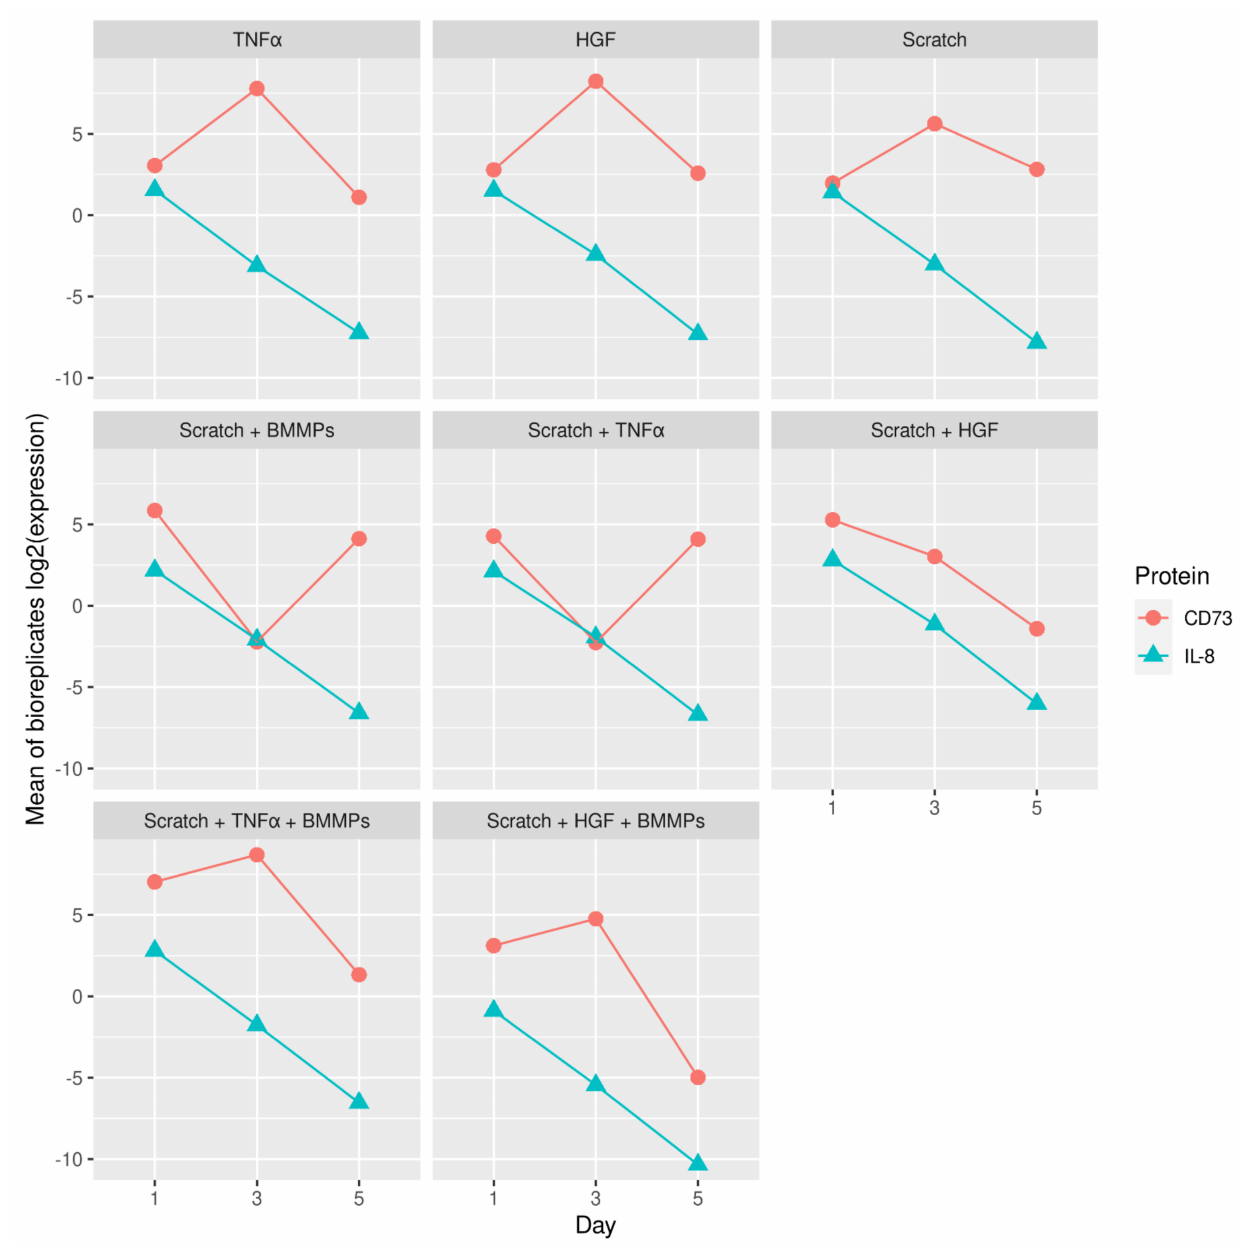
Figure A2. Log2 expression of the mean of three biological replicates for IL-8 and CD73 for the three different time